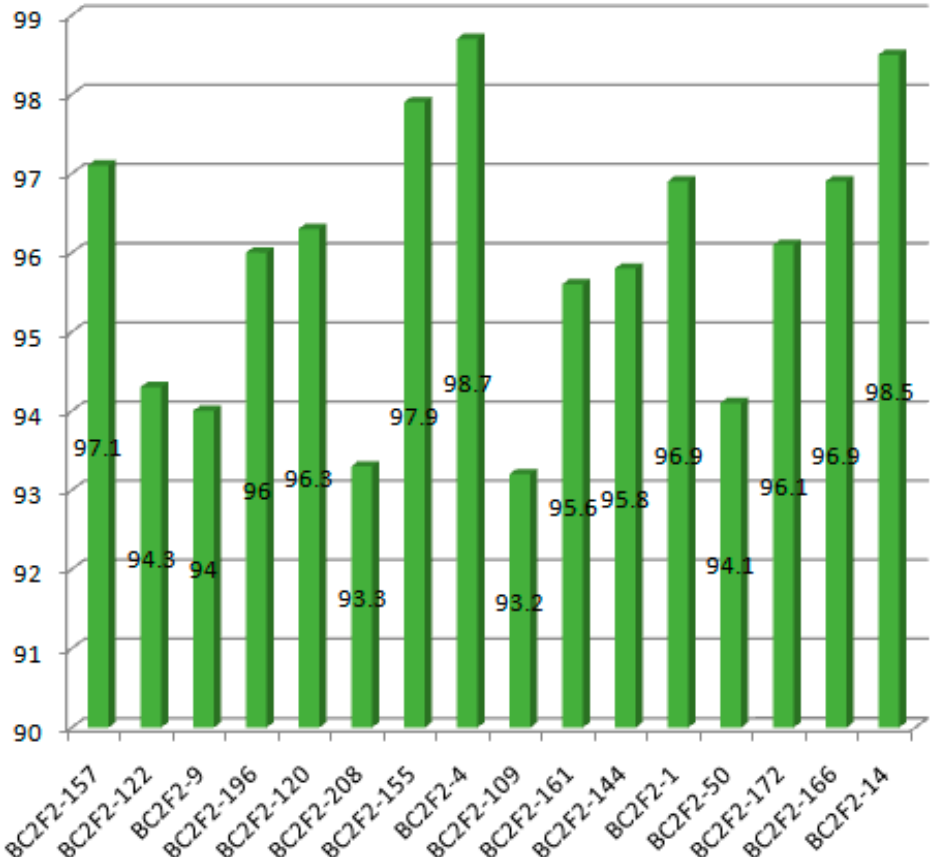
Figure 4. Recurrent parent genome recovery percentage of the improved selected lines.